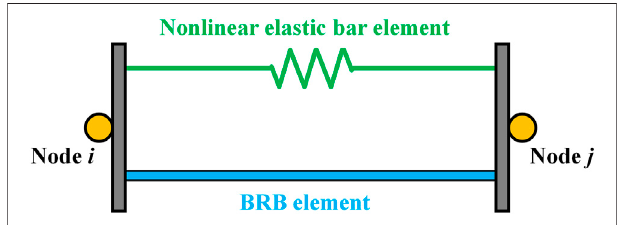
FIGURE 10 | Finite element model of SC-BRB implemented in Perform-3D.